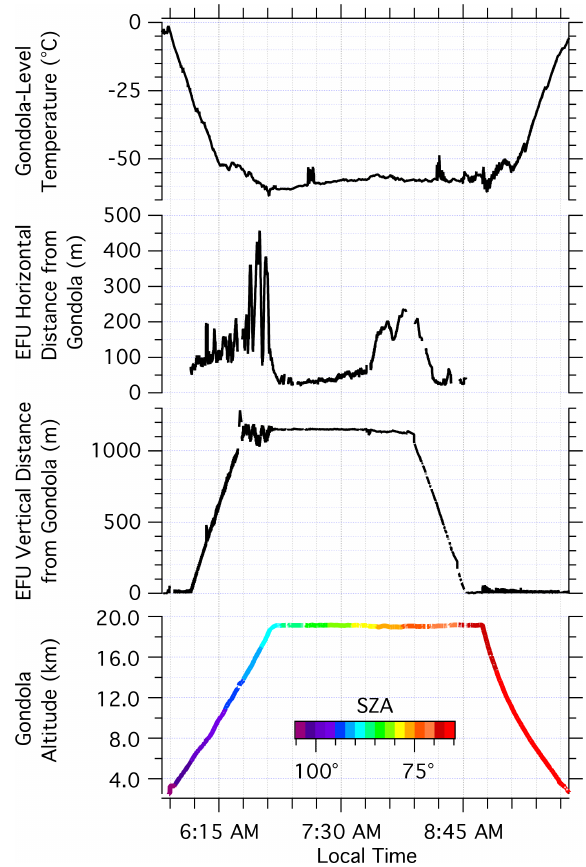
Figure 2. Summary of flight conditions of the 22 January 2021 WY933 zero-pressure balloon fight. Altitude-adjusted solar zenith angle is displayed in